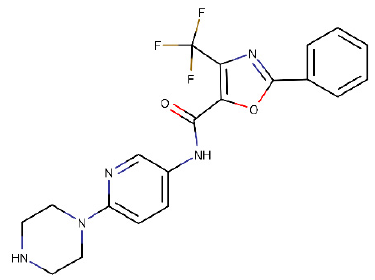
Figure 1. Molecular structure of MMV024937.